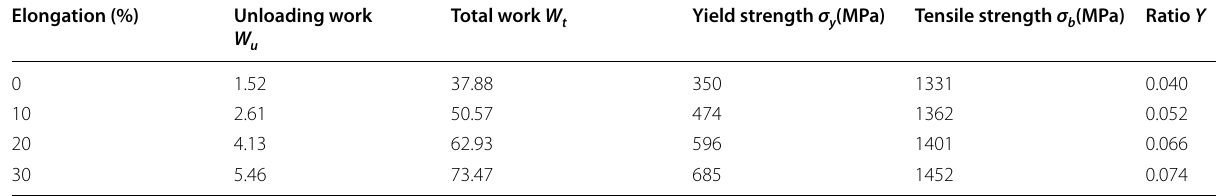
Table 1 Load-depth curve parameters of austenitic stainless steel and mechanical parameters with different elongations Elongation (%)